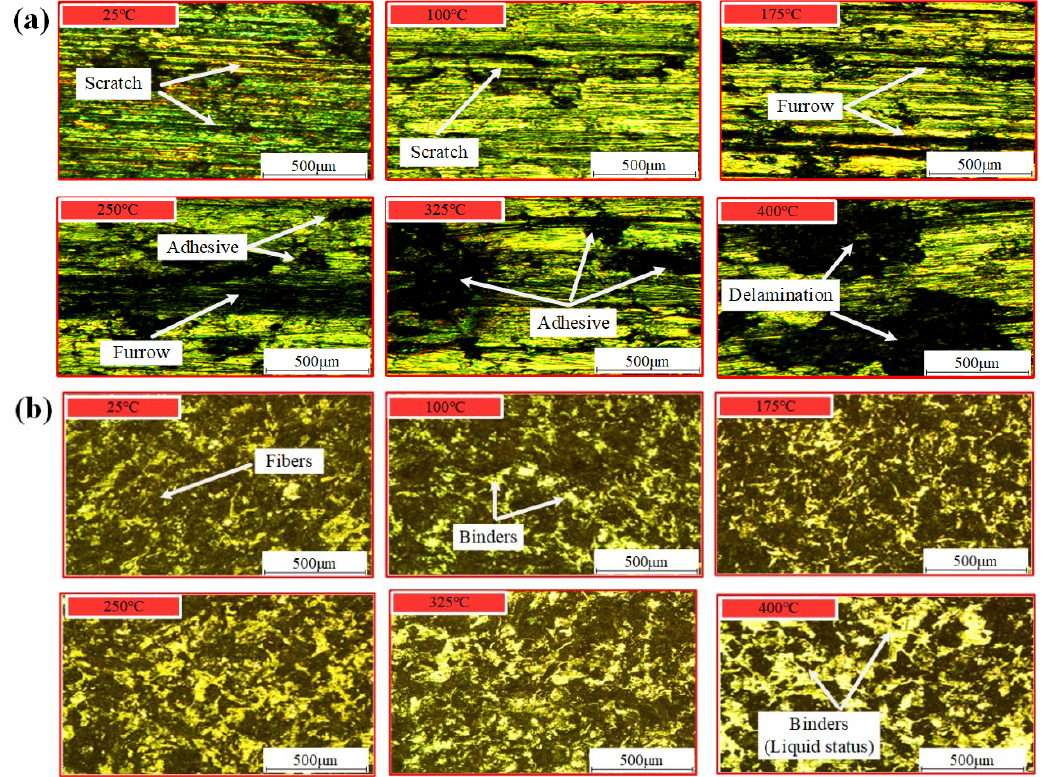
Figure 8. Metallographic micrograph of worn surface of the disc. ( a ) CFM; ( b ) PFM.